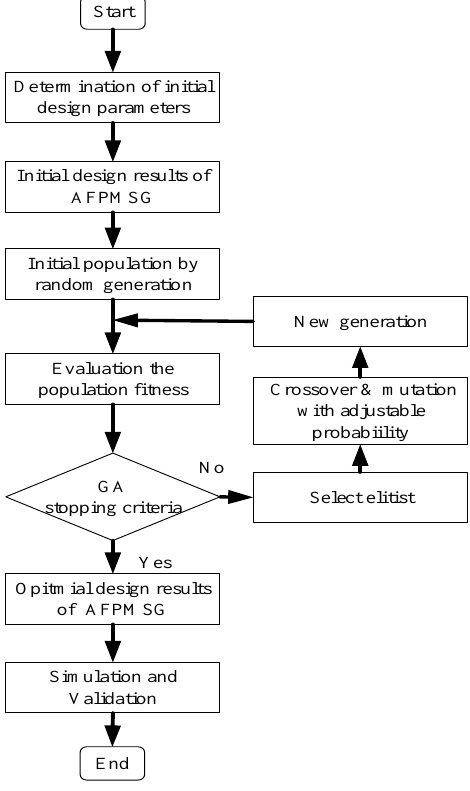
Figure 14. Flowchart of the genetic algorithm (GA) optimization design procedure.